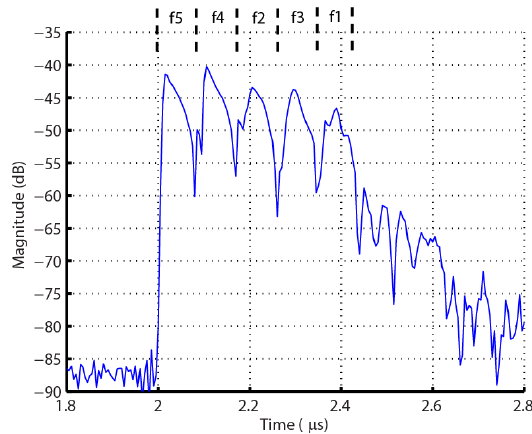
Figure 2. Measured |S | OFC SAW tag time response, in dB, with a 5-chip shorted Bragg 11 reflector grating. The acoustic delay allows the interrogation signal and EM reflections to dissipate before reception at the receiver.